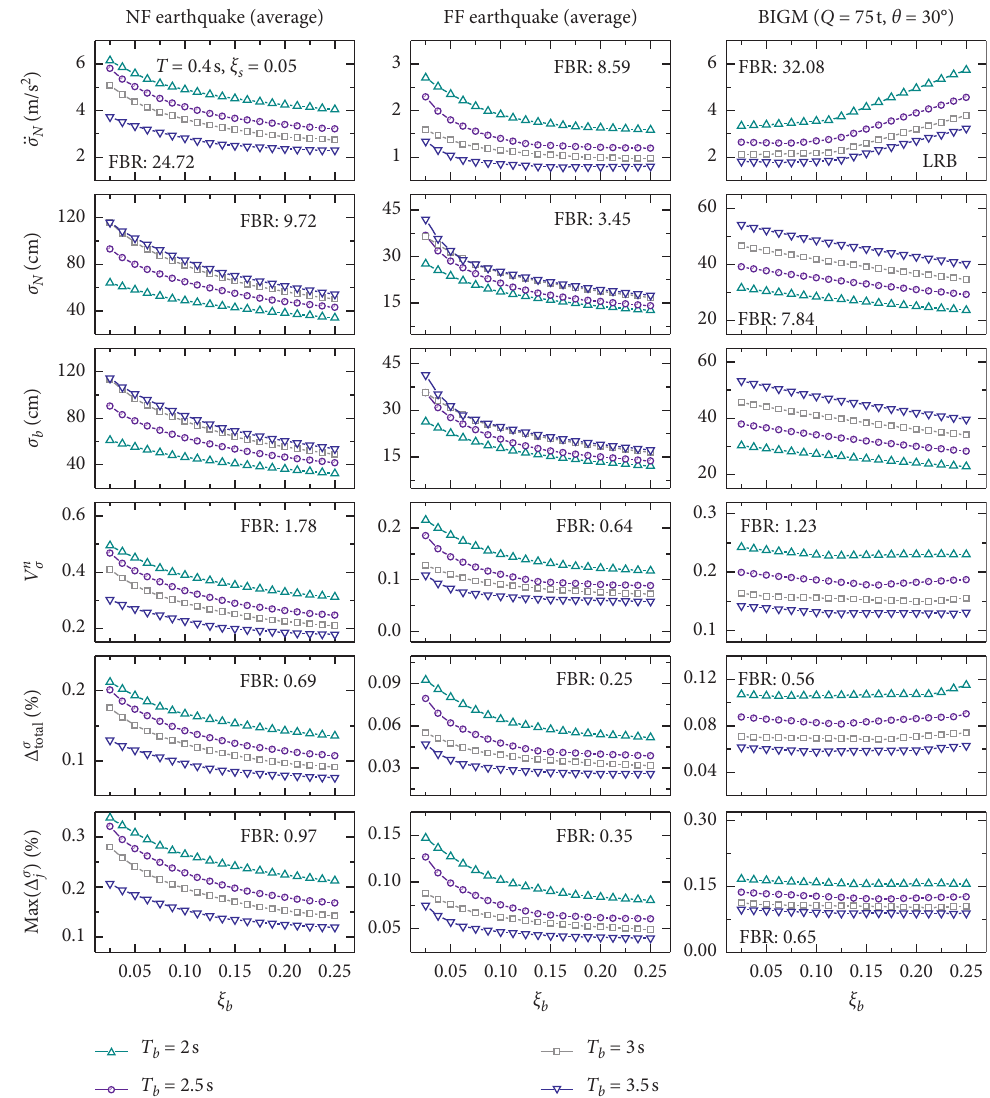
Figure 10: The effect of the isolation damping ratio ( ξ by LRB under earthquake and